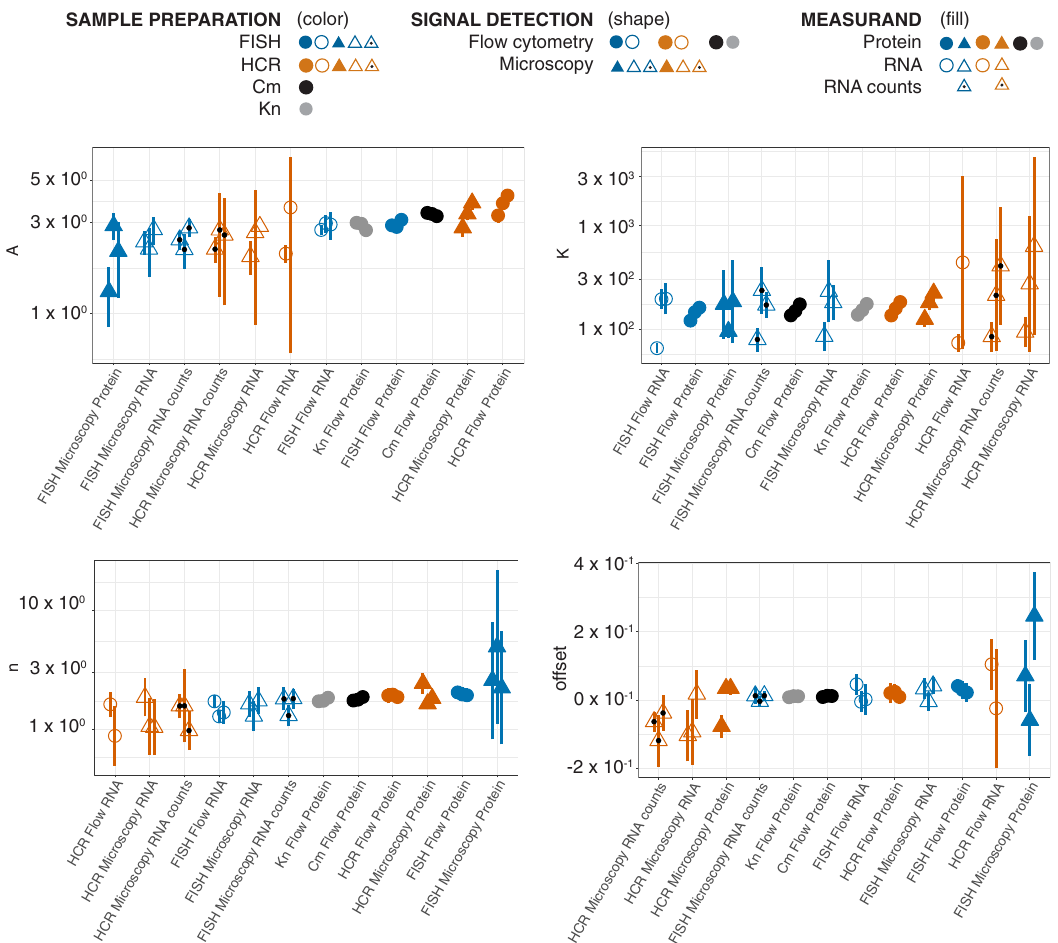
Fig. 2 Evaluation of relative bias in Hill parameters. Hill parameters for fi ts to RPU-normalized data are shown for all 12 methods. Symbols represent parameter estimates for methods according to legend. Error bars indicate 95% con fi dence intervals from nonlinear least-squares fi ts. For each parameter, methods are ordered on x -axis from left-to-right from lowest to highest average parameters